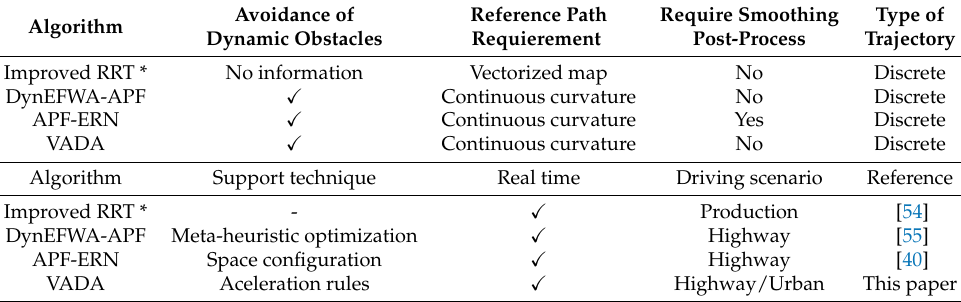
Table 3. Comparison of local path planning